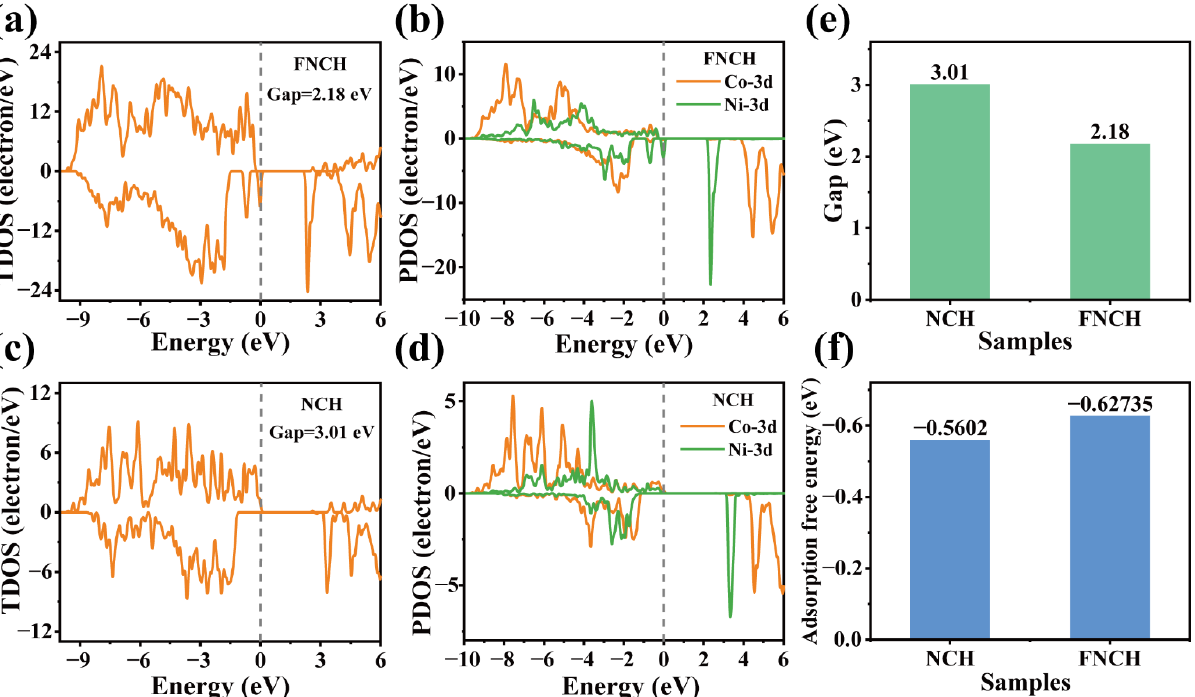
Figure 5. TDOS of FNCH ( a ) and NCH ( c ); PDOS of Ni-3d and Co-3d of FNCH ( b ) and NCH ( d ); ( e ) gap values of FNCH and NCH; ( f ) OH − adsorption energy of FNCH and NCH. Based on the above study, aqueous Zn batteries are assembled using NCH or FNCH